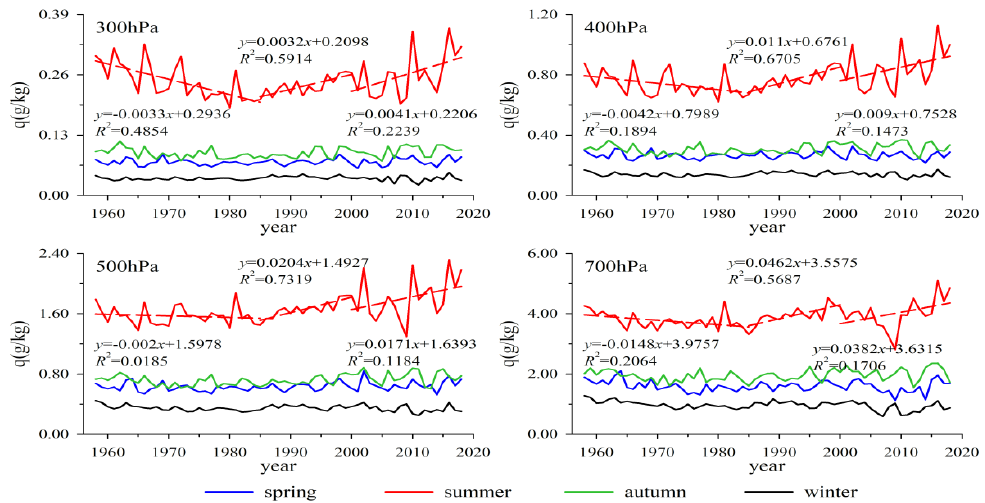
Figure 3. Temporal variation and linear trend of annual average specific humidity of various pressure-latitudes over the region during the period 1958–2018.